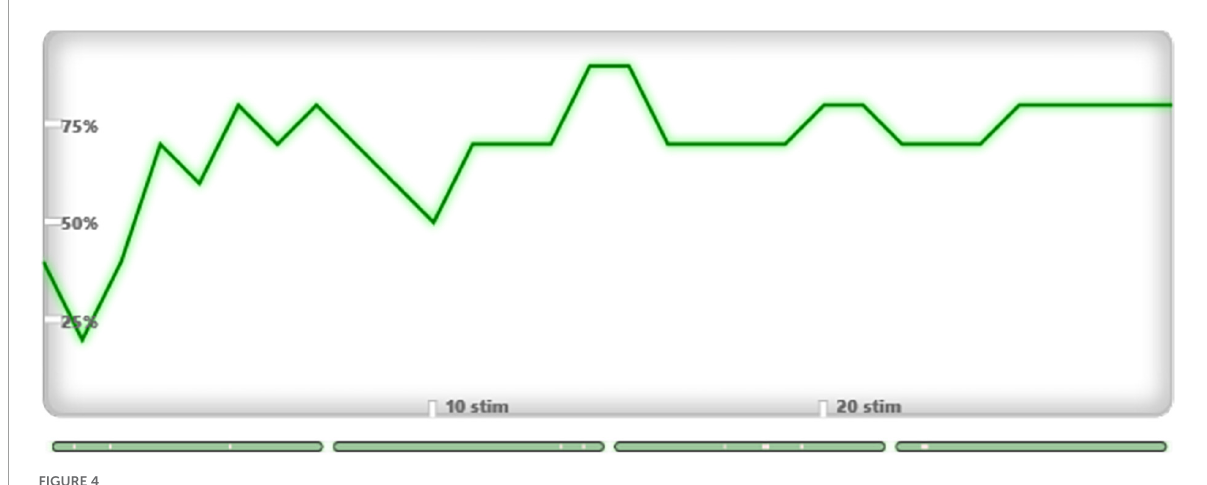
FIGURE4 Plotted line graph of the rate of target stimulus detection for Patient 1, Week 1 (Accuracy: 70%).